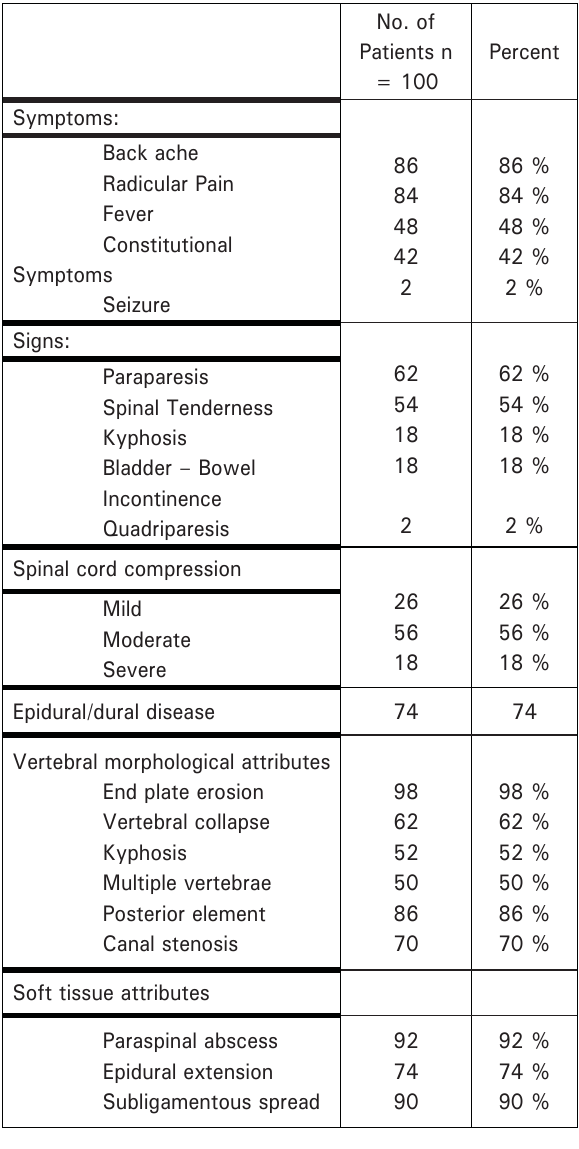
Table 1 : Clinical features and various MRI